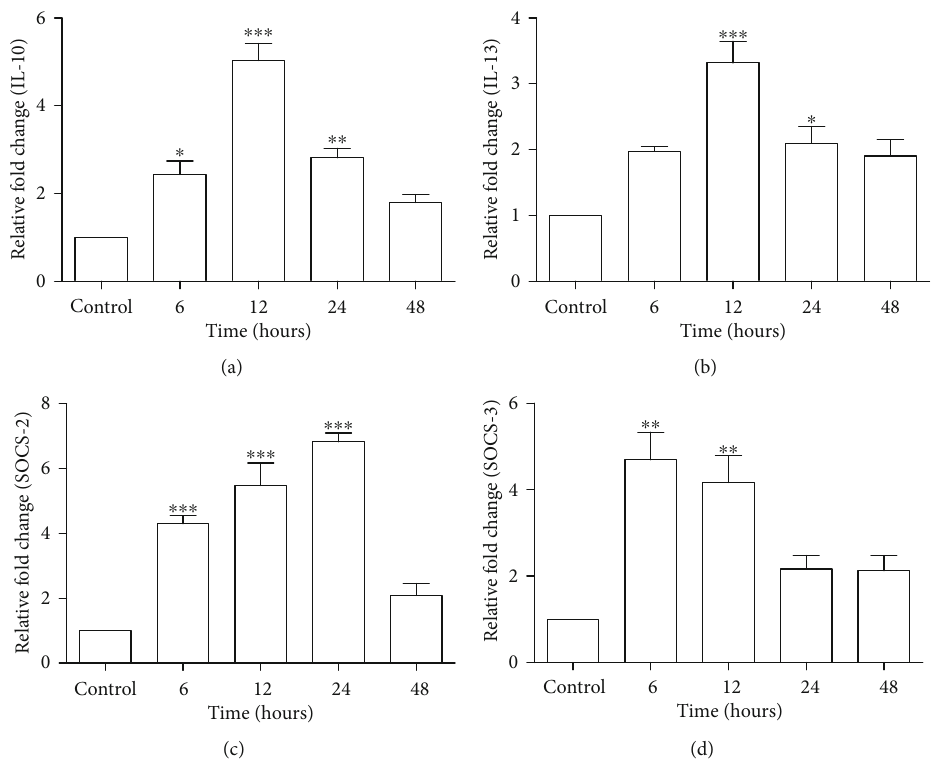
Figure 3: E ff ect of short-term Tacrolimus exposure on gene expression level of cytokines. RT-PCR results are shown in graphical representation depicting the relative fold change in control, 6-, 12-, 24-, and 48-hour treatment groups. (a) IL-10, (b) IL-13, (c) SOCS-2, and (d) SOCS-3. Data is represented as mean ± SEM ( n = 6 ) and normalized with the expression of a housekeeping gene, GAPDH. ∗ P ≤ 0 : 05 , ∗∗ P ≤ 0 : 01 , and ∗∗∗ P ≤ 0 : 001